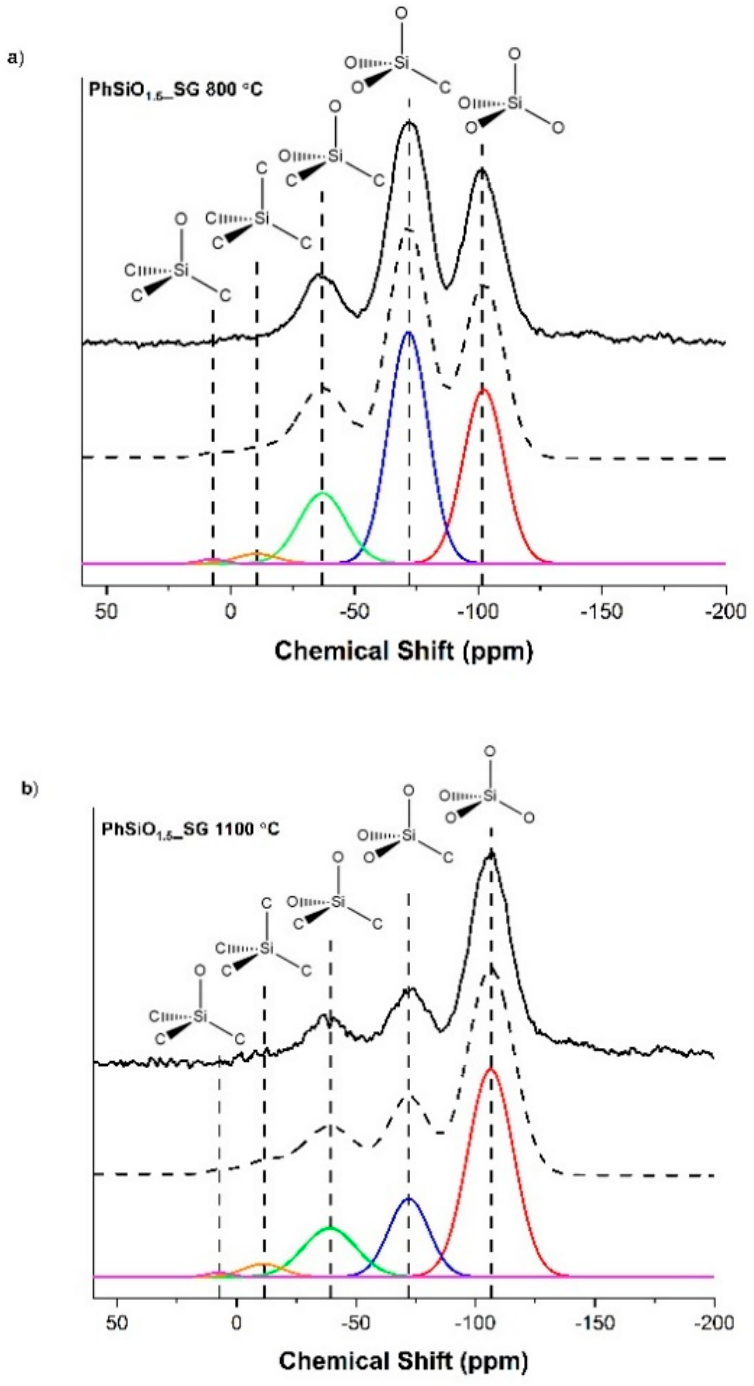
Figure 5. 29 Si MAS NMR for PhSiO 1.5 _SG samples. ( a ) Sample pyrolyzed to 800 °C with peaks at ~ − 102 ppm, − 72 ppm, − 38 ppm, − 11 ppm and 7 ppm, corresponding to SiO 4 , SiO 3 C, and SiO 2 C 2 , SiC 4 and SiOC 3 tetrahedra, respectively. ( b ) Sample pyrolyzed to 1100 °C with peaks at ~ − 107 ppm, − 72 ppm, − 38 ppm, − 11 ppm and 7 ppm corresponding to the same structural units given in ( a ).